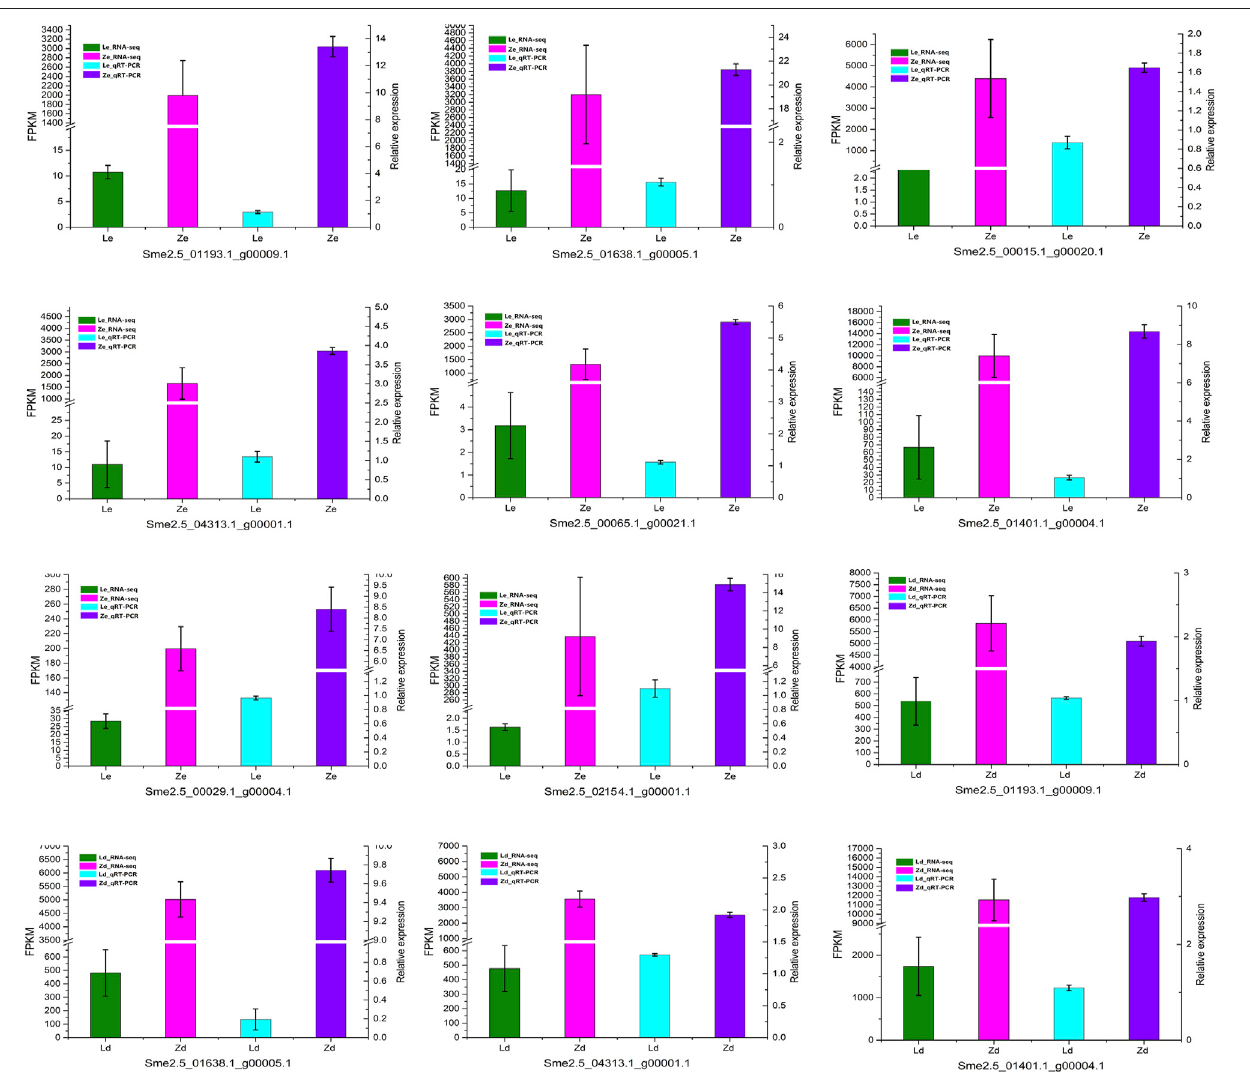
FIGURE 5 | qRT-PCR con fi rmation of the differentially expressed genes identi fi ed by transcriptome analysis of peel samples from the fruit apex (Ld and Zd) and under the calyx (Le and Ze) of L and Z line eggplants, respectively.